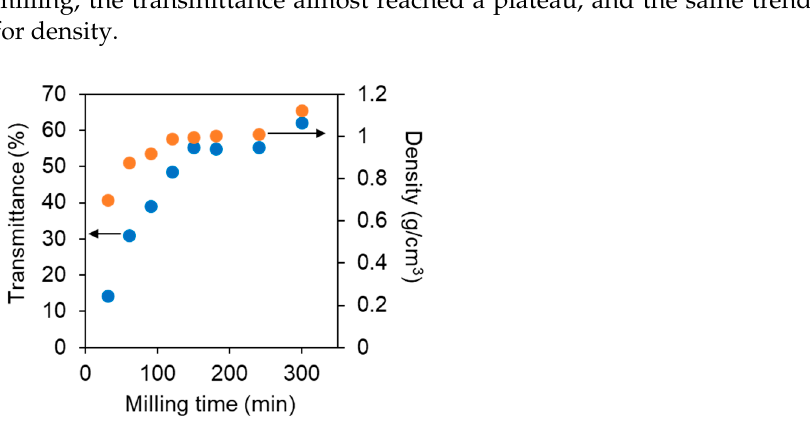
Figure 9. Dependence of transmittance at 600 nm (blue circle) and density (orange circle) of the cast film on milling time of chitin.